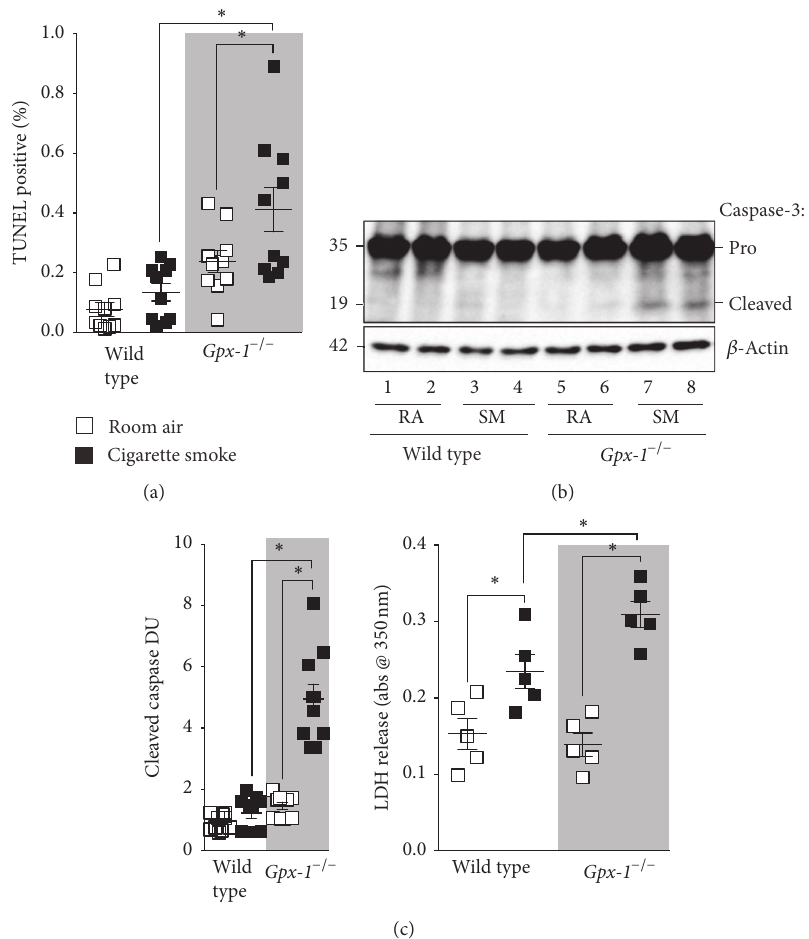
Figure 6: Gpx-1 deficient mice have heightened ER stress in their lungs following exposure to cigarette smoke. Gpx-1 −/− and wild type mice were exposed to cigarette smoke daily for 1 year. (a) TUNEL analysis was performed on lung tissue from each mouse group. (b) Enhanced lung tissue caspase-3 cleavage coincided with (c) elevated LDH into BALF of Gpx-1 −/− exposed to cigarette smoke. Every lane in (b) represents an individual mouse and densitometry units (DU) of pixel intensity expressed as a ratio to total caspase-3 levels. Dot plots are represented as mean ± SEM, where each measurement was performed on 3 independent days on 6 donors/group. ∗ denotes a 𝑝 value < 0.05, when comparing both treatments connected by a line, determined by 2-way ANOVA with Tukey’s post hoc test ( > 2